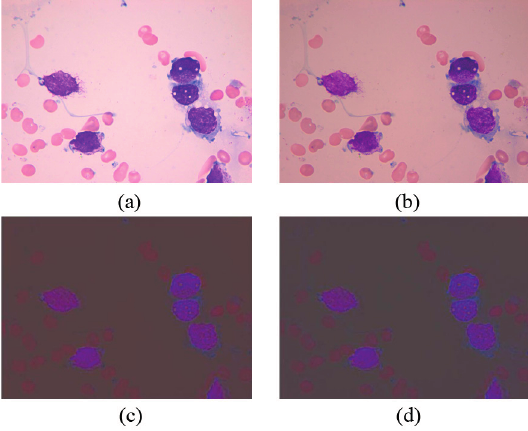
Figure 1. ( a , b ) Original RGB image under different light conditions; ( c ) Rg chroma space under light condition of (a); ( d ) Rg chroma space under light condition of ( b